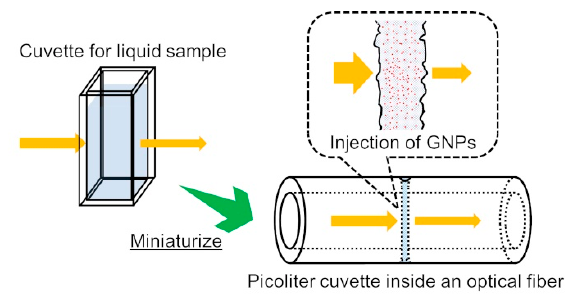
Figure 1. Conceptual diagram of a picoliter cuvette inside an optical fiber. Structure of the picoliter cuvette with a space penetrating the optical fiber.